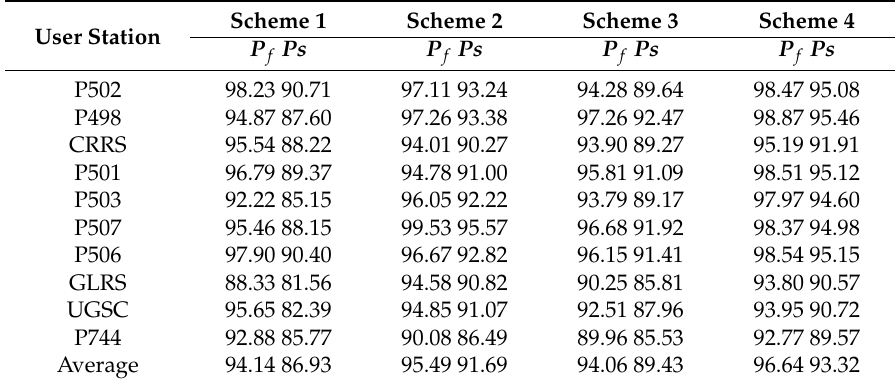
Table 2. 5-min fix rate ( P f ) and success rate ( P s ) with different schemes.